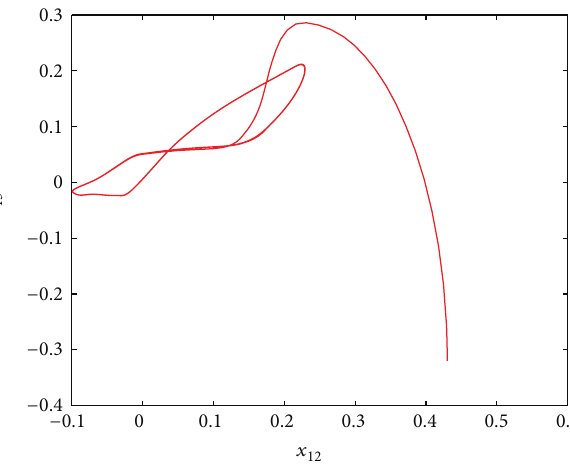
Figure 3: Phase response of state variables 𝑥 12 and 𝑥 13 in Example